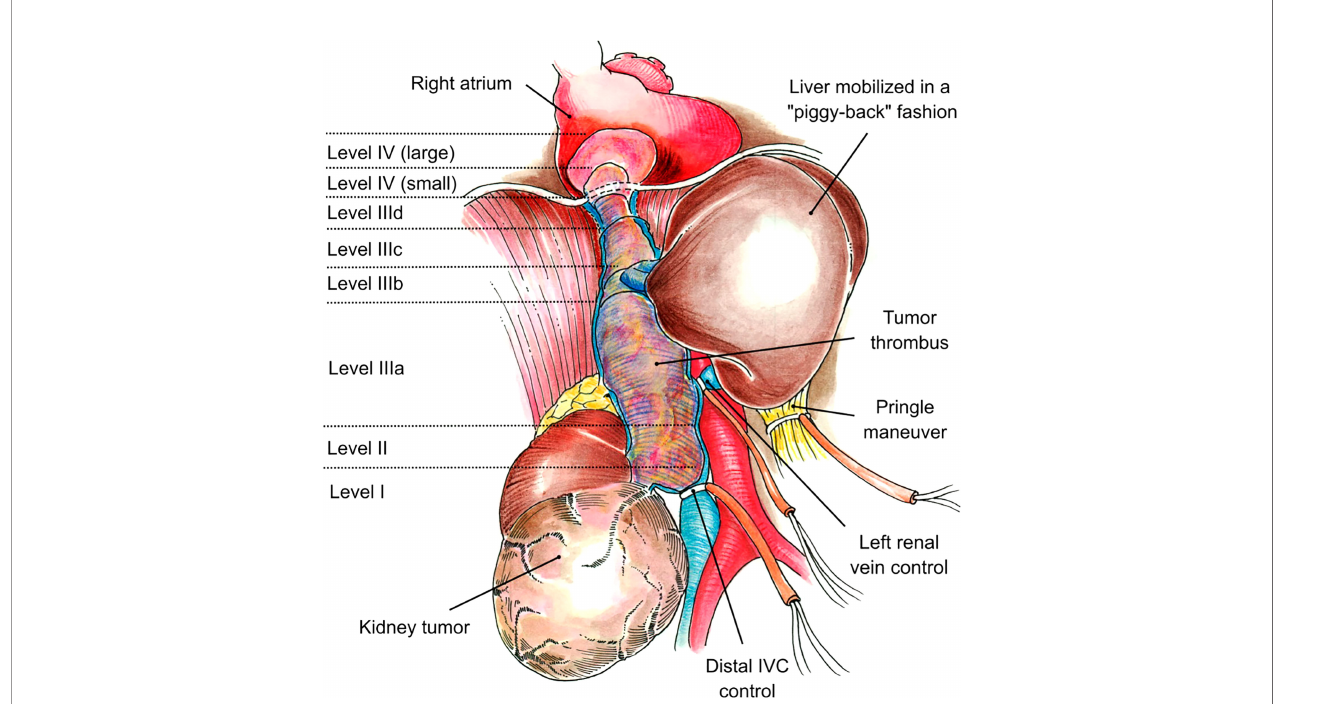
FIGURE 1 | Neves and Zincke Classi fi cation System was used for level II and IV thrombus. Level III thrombi were classi fi ed as level IIIa (retrohepatic), level IIIb (hepatic), level IIIc (suprahepatic, infradiaphragmatic), or level IIId (supradiaphragmatic,